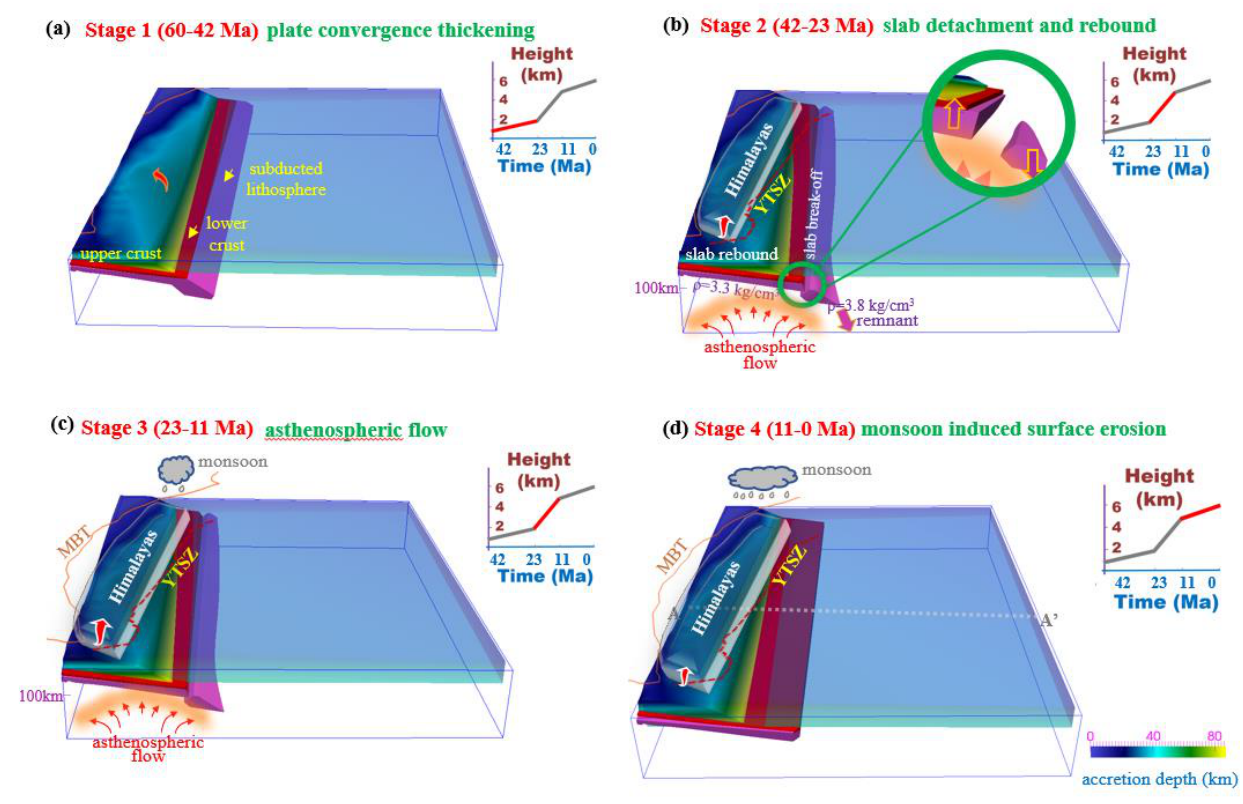
Figure 3. The four stages of the Himalayan uplift based on 3-D subduction modeling. Red arrows denote the elevation of the Himalayas. MBT, main boundary thrust; YTSZ, Yarlung–Tsangpo suture zone. The insets are modified from Ding et al. [4]. ( a ) Plate-convergence-induced thickening (60 − 42 Ma). ( b ) Progressive uplift of the Himalayas caused by slab detachment and rebound (42 − 23 Ma). ( c ) Upward asthenospheric flow causing rapid uplift of the Himalayas (23 − 11 Ma). ( d ) Slowed uplift of the Himalayas affected by surface erosion (11 − 0 Ma).